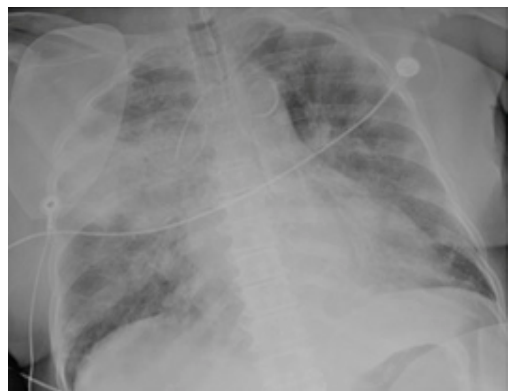
Figure 7. Dense infiltrate in the right upper lobe.